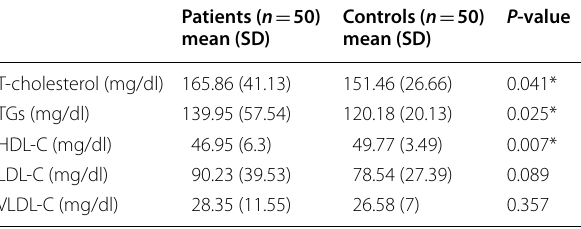
HDL-C, high-density lipoprotein cholesterol; LDL-C, low-density lipoprotein cholesterol; T-cholesterol, total cholesterol; TG, triglycerides; and VLDL, very-low- density lipoproteins * P -value < 0.05 is considered statistically significant